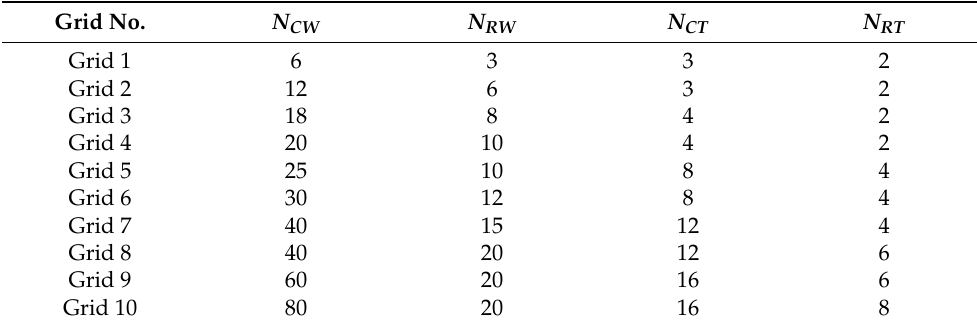
Table 1. Number of cells included at each grid level used for convergence study. Grid